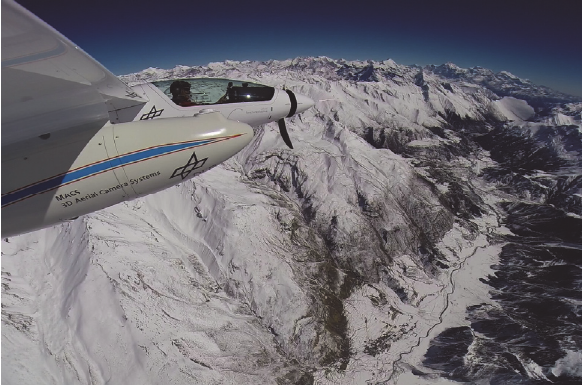
Figure 5. The Kali-Gandaki Valley